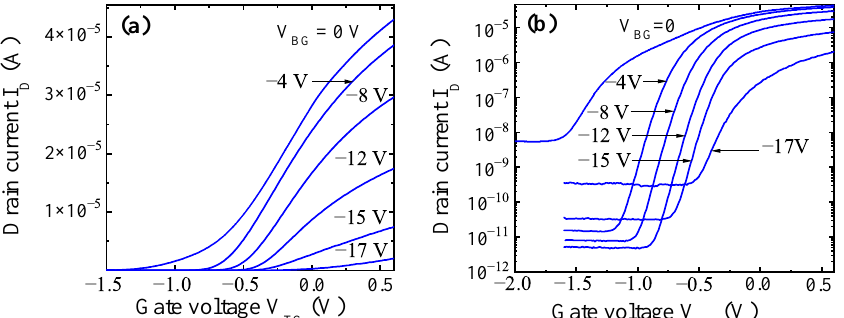
Figure 4. Transfer current–voltage characteristics of a FinHEMT at the linear ( a ) and semi-logarithmic scales ( b ) for one of the transistors with L TG = 2 µm, W G = 5